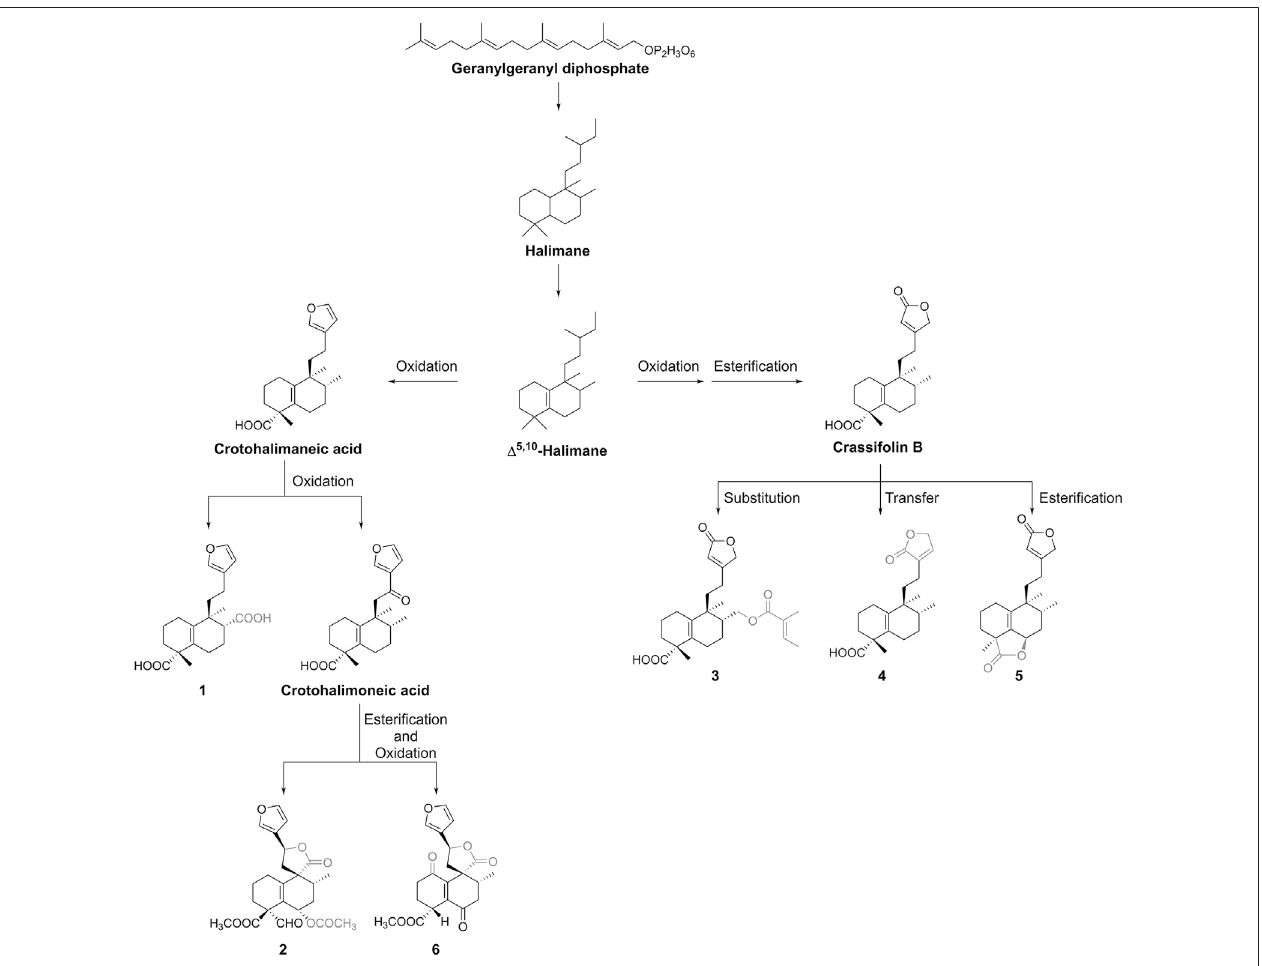
FIGURE 9 | Hypothetical biosynthesis pathway of new diterpenoids.